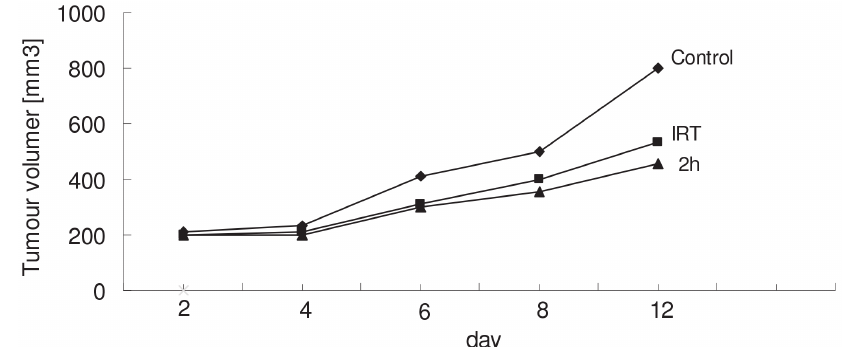
FIGURE 3 - Tumor growth inhibition of colo205 xenografts in nude mice by compound 2h administered